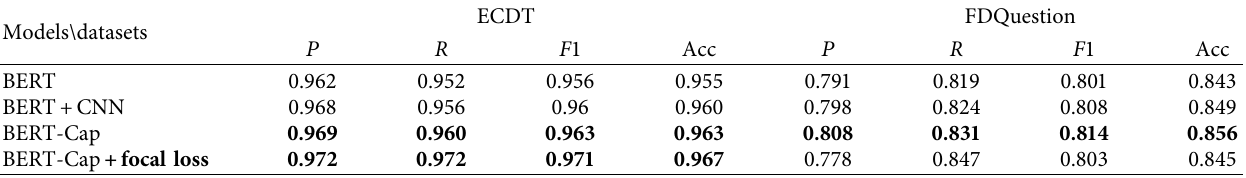
Table 4: The performance of different methods on two Chinese datasets.